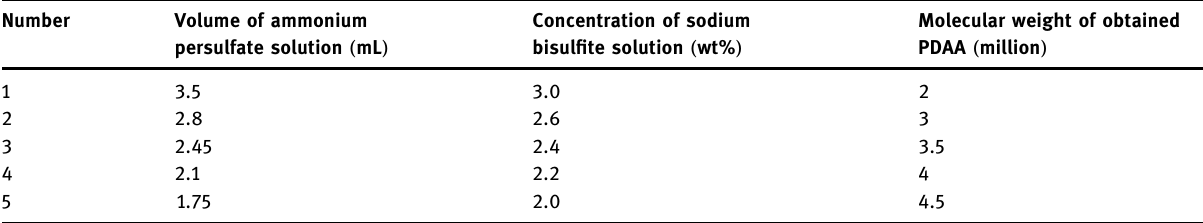
Table 1: Volume of ammonium persulfate solution, concentration of sodium bisul fi te solution and the molecular weight of obtained PDAA